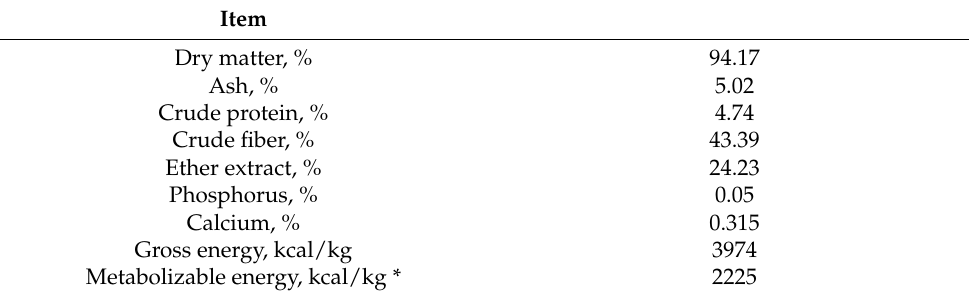
Table 2. Macauba pulp composition. Item Dry matter,